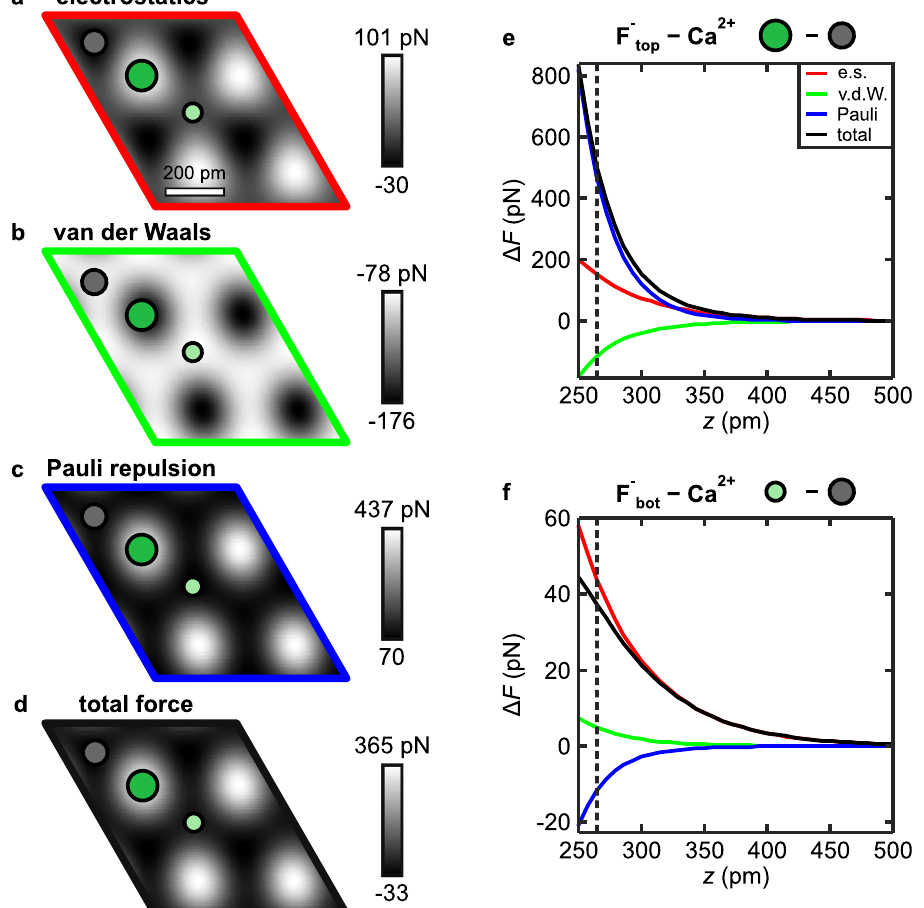
Figure 4. ( a – c ) Interaction decomposed images [of a CaF 2 (111) supercell] at a tip-sample distance of z = 272 pm , and ( d ) the total force obtained by summing all three contributions obtained with the probe particle model. ( e , f ) Individual contributions to the atomic force contrasts (cid:31) F as a function of tip-sample distance z . The dashed line marks the tip-sample distance of the images in ( a – d ). The colors match the frames of ( a – d